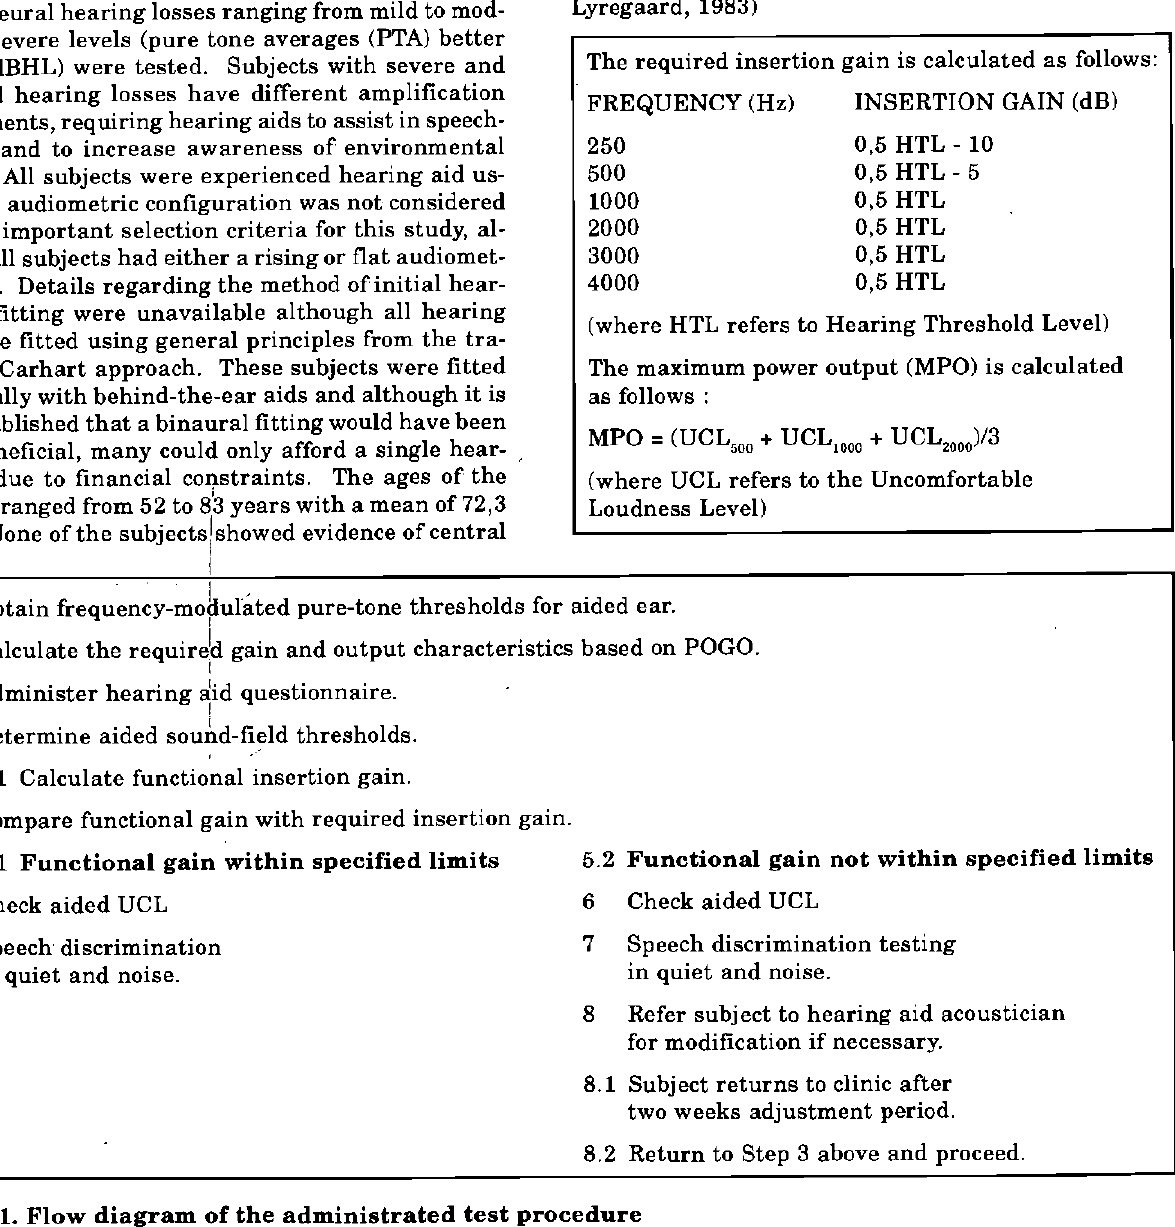
Table 1. Calculation of gain and maximum power